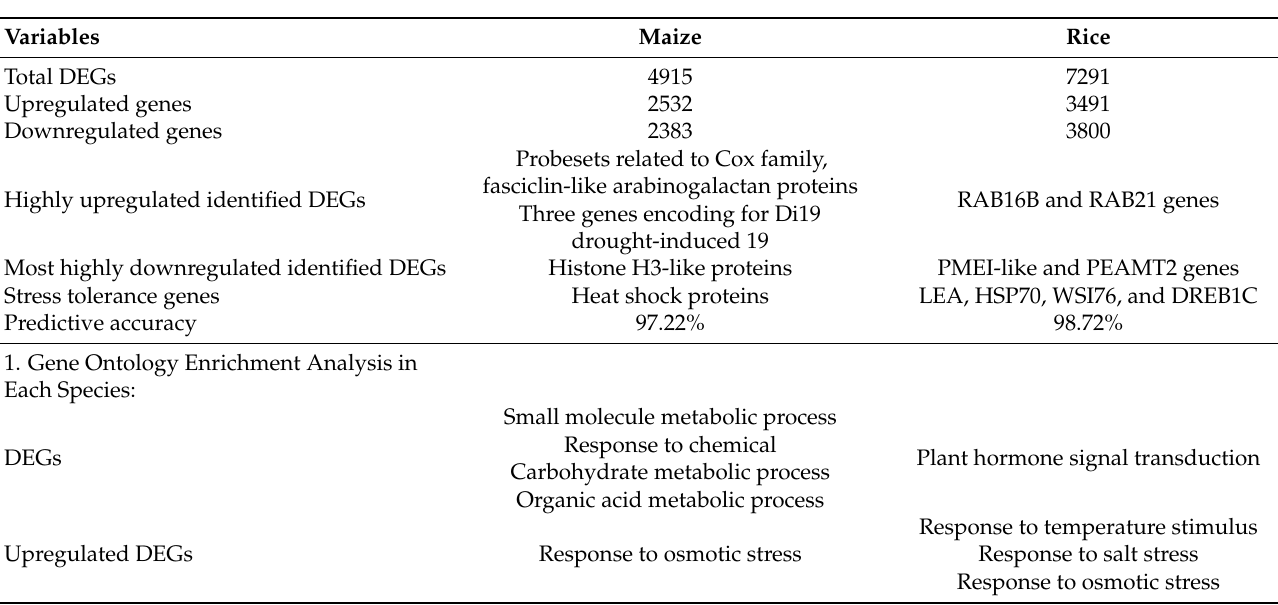
Table 4. Meta-analysis on the transcriptional response of Rice and Maize to drought stress, according to a study by Tahmasebi et al.